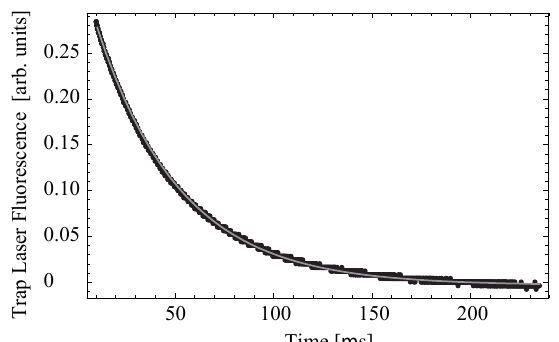
Figure 25. Fluorescence from the F = 4 → F (cid:48) = 3 transition as a function of time after blocking the repump laser. An exponential fit gives a time constant for the decay of 42.42 ± 0.05 µ s. The trap laser power was 75 ± 7 mW, the repump power was 50 ± 5 mW, and the magnetic field gradient was ∼ 7 G/cm.